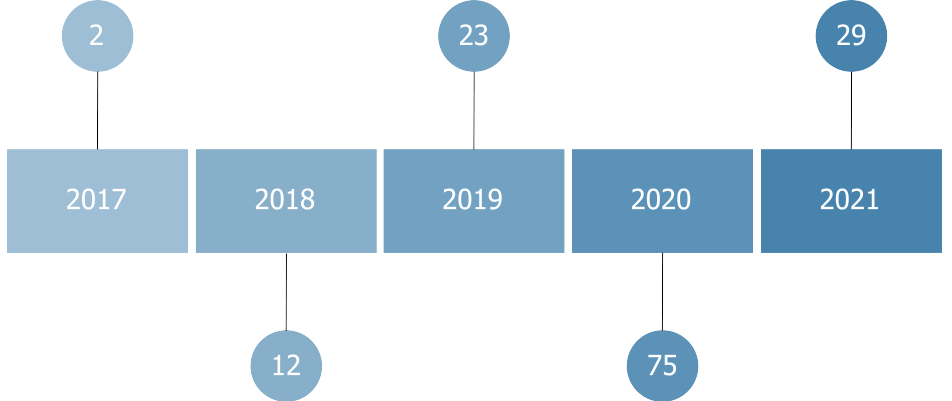
Figure 3. Number of published articles per